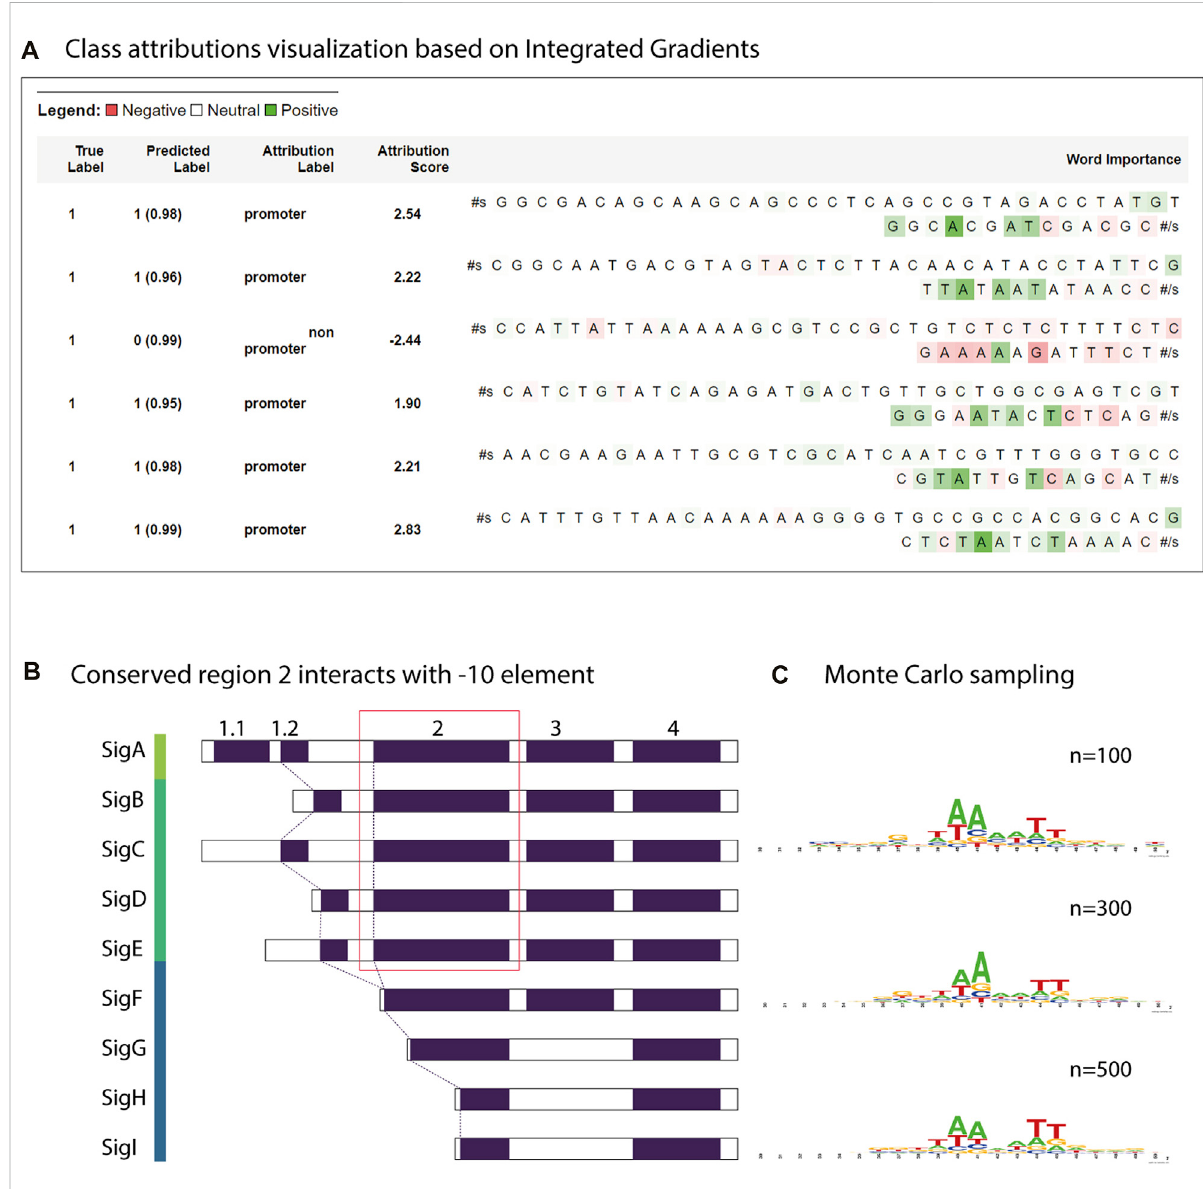
FIGURE 7 Motif analysis using attribution weights and reverse enrichment through Monte Carlo sampling. (A) Class attributions visualization of a few strong promoters in Synechococcus elongatus sp. UTEX 2973 and a non-promoter sequence. (B) Transcription factor groups in Synechocystis sp. PCC 6803. The relatively conserved region two in group 1 and group 2 retains a motif similar to the consensus -10 element TATAAT. (C) The motif learned by the trained model discovered by Monte Carlo